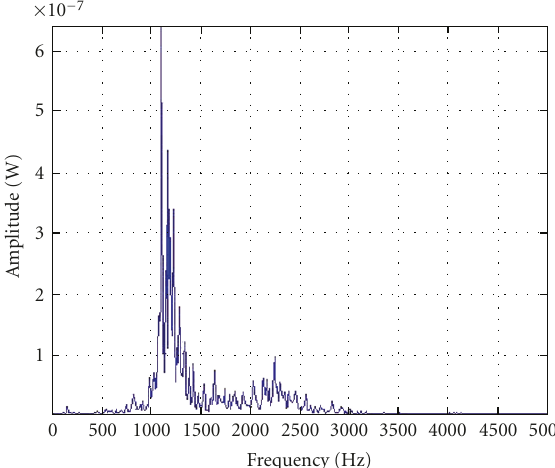
Figure 3: Vocal signal amplitude versus time (TEP3).